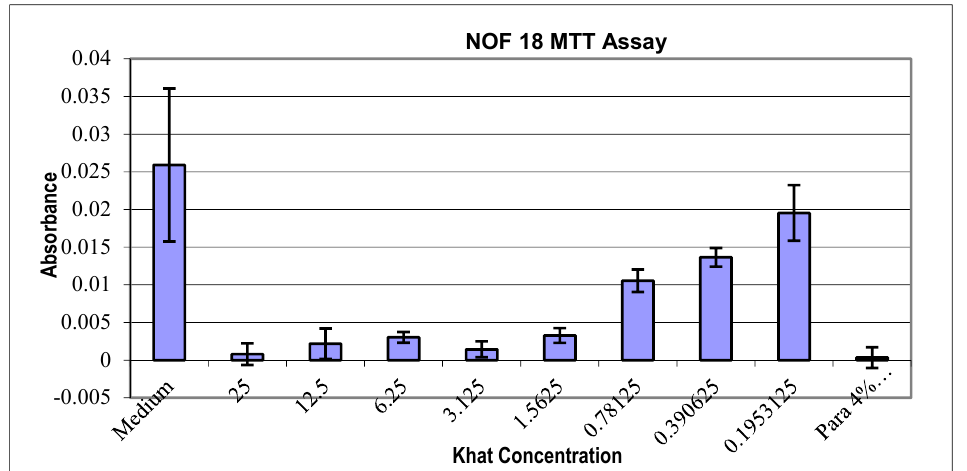
Figure 4. Absorbance from MTT Assay for NOF 18 cells treated with different concentrations of Khat solution (25 mg/mL to 0.195 mg/mL). Medium with only NOF 18 was used as a negative control while 4% paraformaldehyde was used as a positive control showing complete cell death.